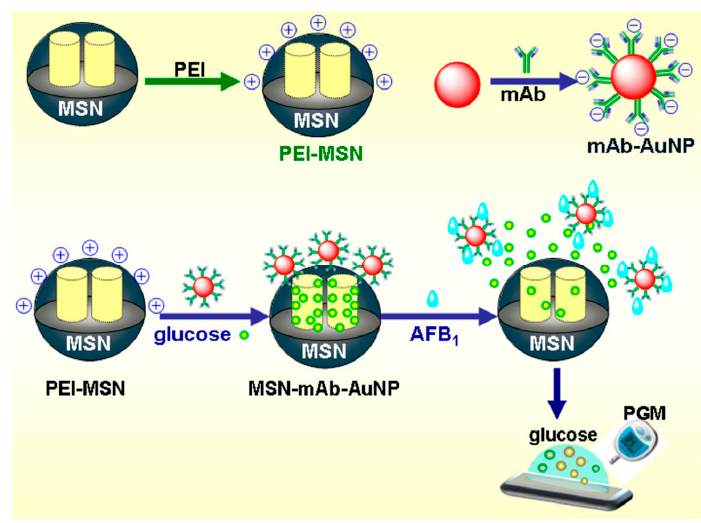
Figure 2. Schematic illustration of PGM-based immunosensing protocol using mAb-AuNP-gated PEI-mesoporous silica NPs loading with glucose. Reprinted with permission from [8]. Copyright (2014) American Chemical Society.